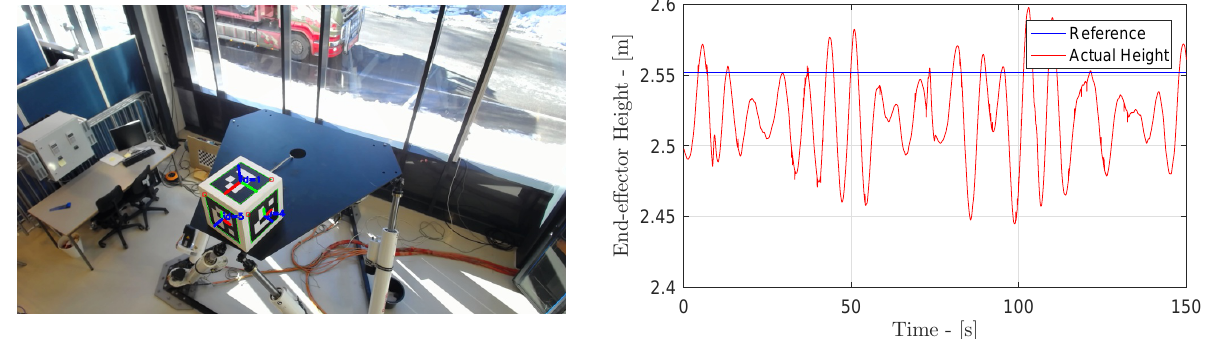
Figure 23: Experimental location number 3 seen from the camera.